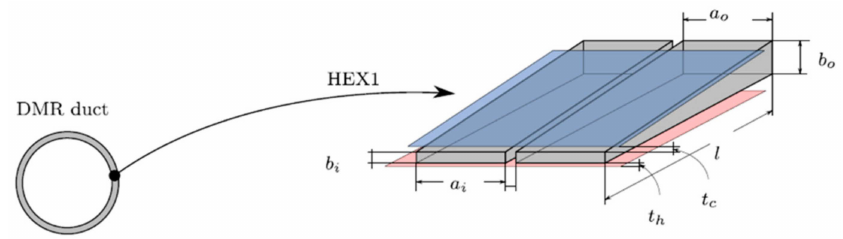
Figure 9. Exchanger layout